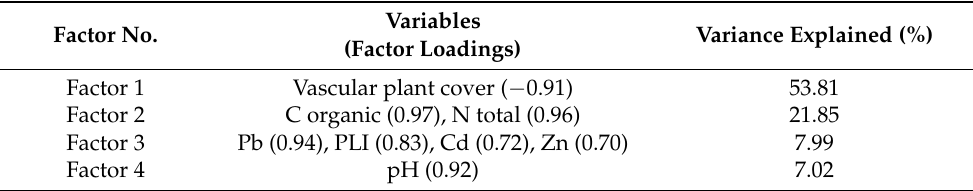
Table 1. Factors derived from habitat properties, i.e., soil chemical parameters and vascular plant cover. Factor loadings are given in parentheses; only variables with factor loadings greater than 0.7 are listed. The percentage of explained variance for each factor is provided.